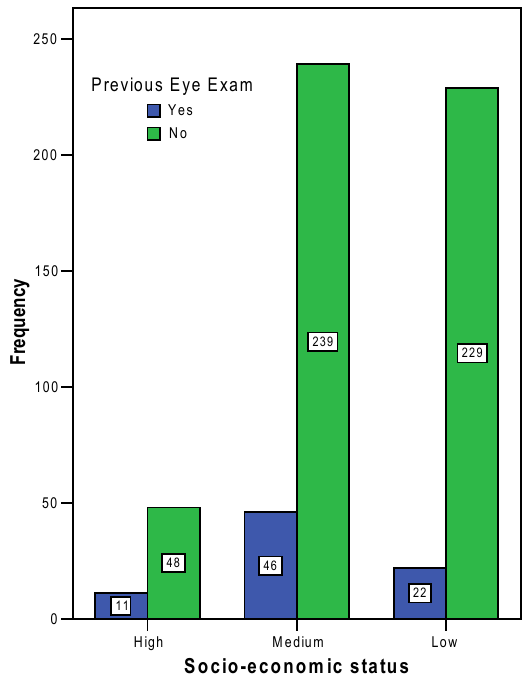
Figure 2: Distribution of Previous Eye Examination with Pa - rental SES